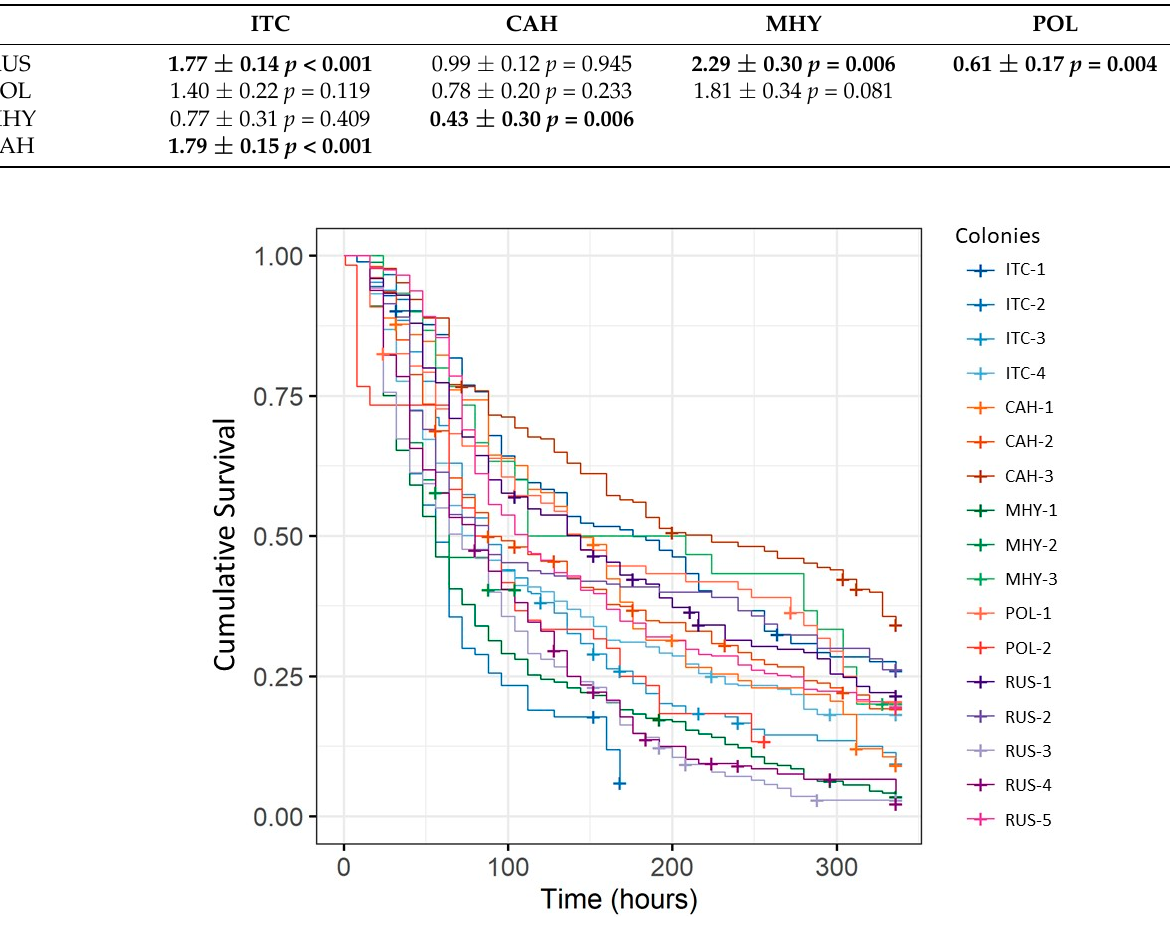
Figure 2. Survival of IAPV-inoculated worker honey bees from colonies of different stocks. Each line represents survival time of workers from one colony of a particular stock (ITC = “Italians” from California, CAH = “Carniolans” from Hawaii, MHY = Minnesota “Hygienics”, POL = POL-line, and RUS = “Russians”). Average survival, as well as survival dynamics, differed profoundly among colonies. “ + ” indicates censored data.